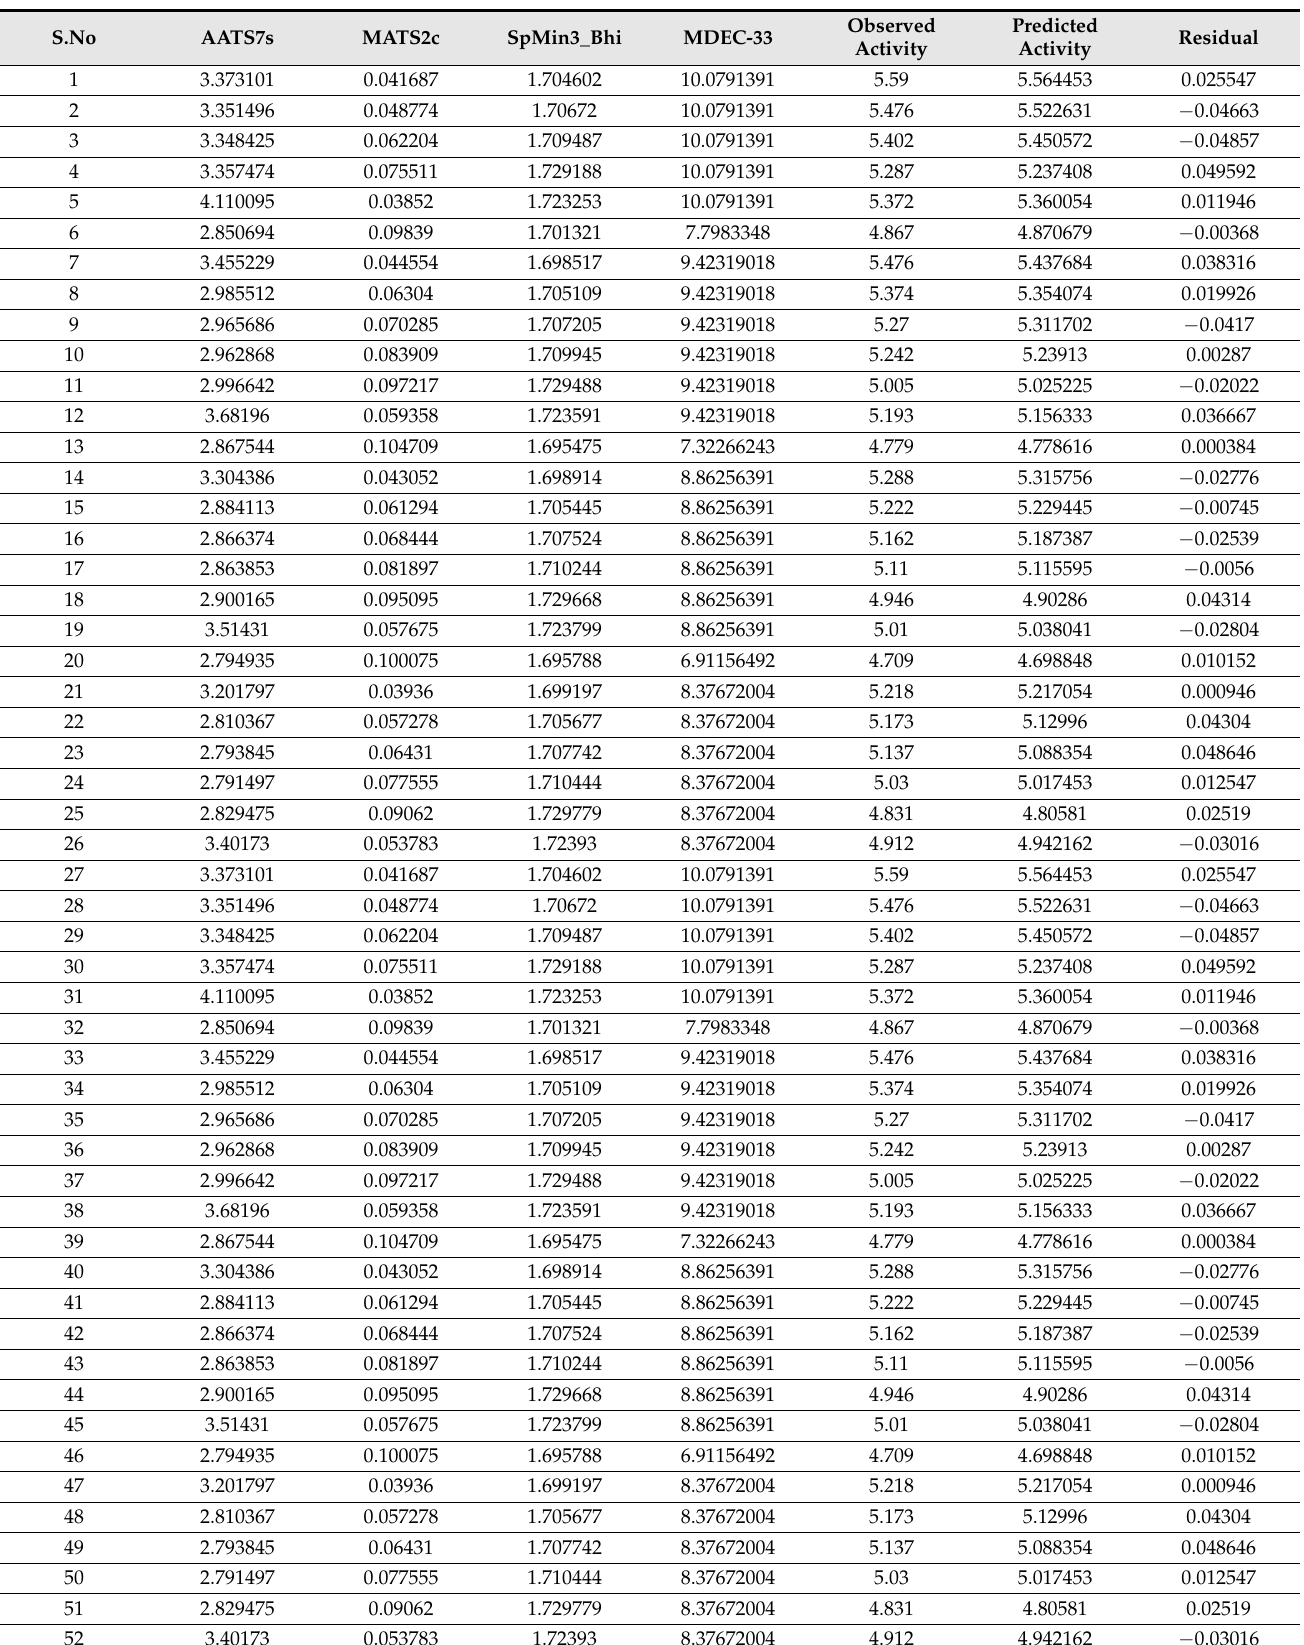
Table 3. pKi values of the original data set predicted by the best model